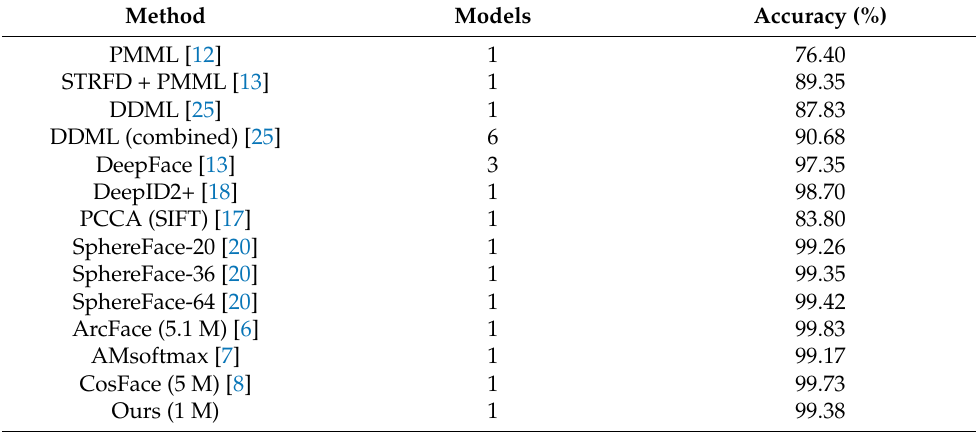
Table 2. Comparison of our method and other methods on the